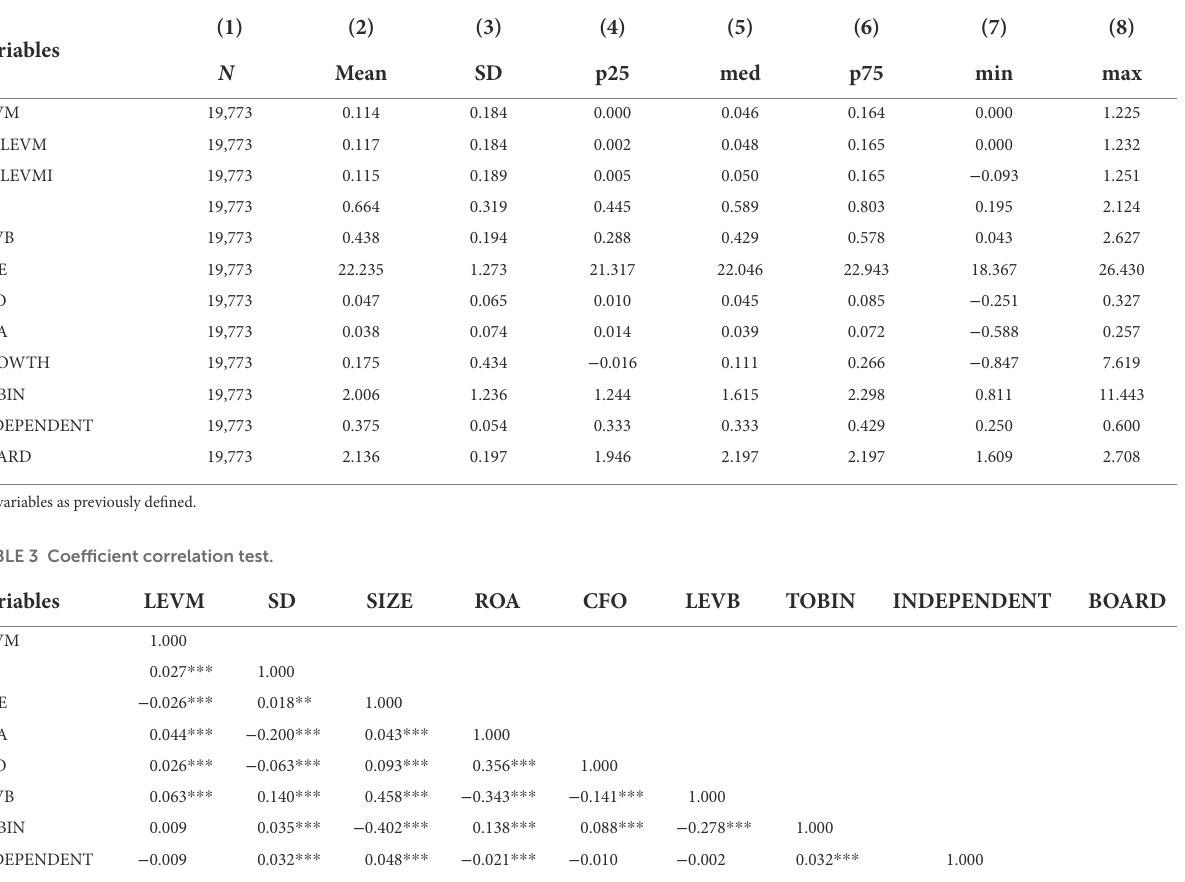
TABLE 2 Descriptive statistics of main variables.